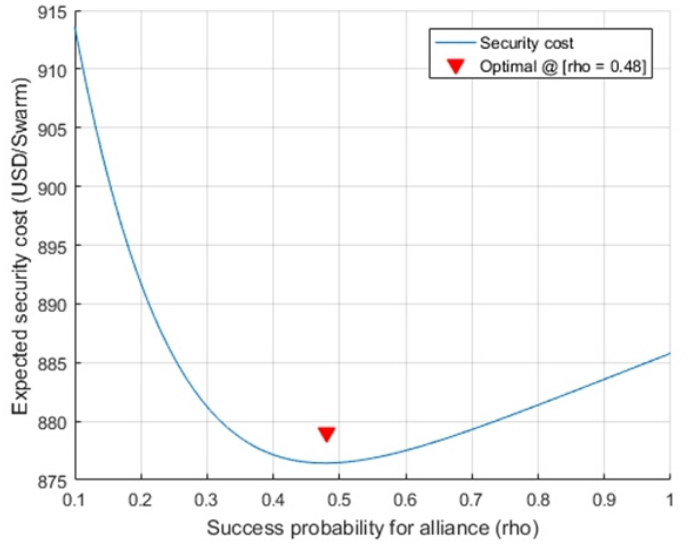
Figure 4. Optimization practice for the drone swarm